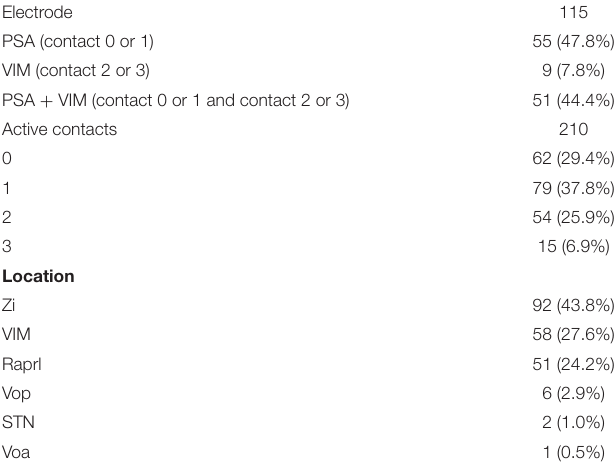
TABLE 2 | Locations of active contacts for chronic